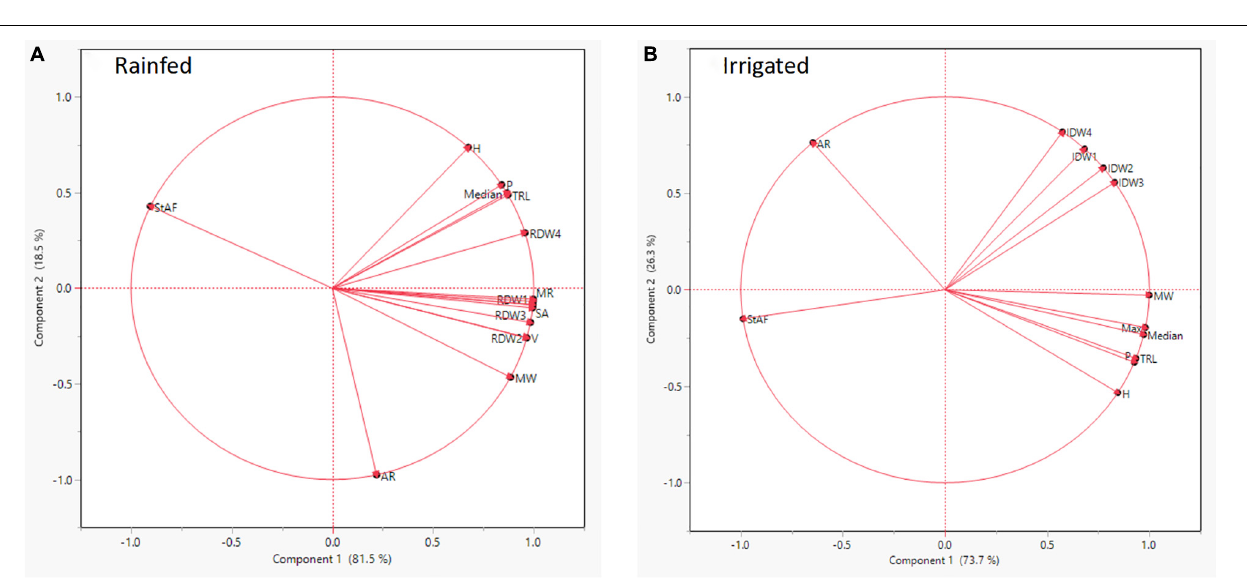
FIGURE 7 | Root traits of alfalfa populations in rain-fed conditions were analyzed using the Rhizovision program. Representative of camera captured and Rhizovision analyzed images of PI478573 (A) , PI502521 (B) , and Bulldg805 (C) are shown.